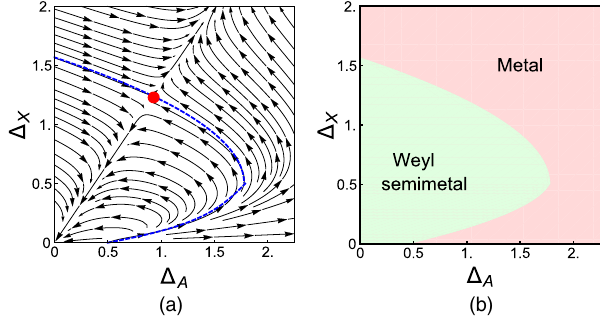
FIG. 17. (a) The renormalization-group flow diagram and − Δ − Δ plane (b) corresponding phase diagram in the Δ plane obtained AM SO A X 1 . There is only one 1 , where X ¼ SO; AM . There exists expansion for ϵ from ϵ expansion for ϵ m m ¼ d d ¼ Δ 3 ϵ 6 ϵ 9 ϵ = 4 (red dot). The = 5 , Δ = 10 . The QCP at Δ only one QCP at Δ AM ¼ SO ¼ m A ¼ d X ¼ d A ¼ ϵ = 2 in the absence of a CSB disorder now possesses two d unstable directions. Note that a new critical point emerges from the competition between the chiral and nonchiral disorder